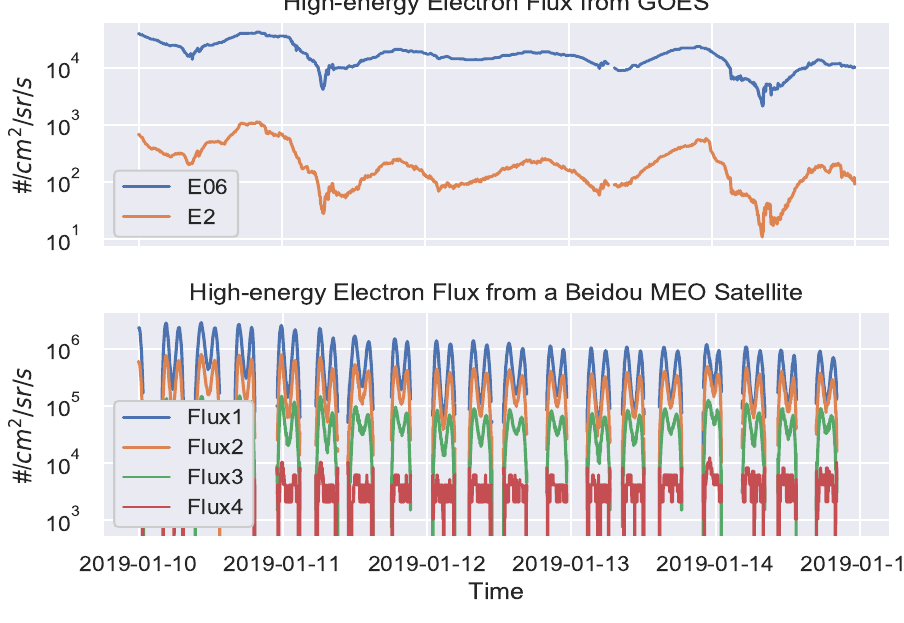
Figure 2. High-energy electron flux observations from 2019-01-10 to 2019-01-14 for GOES-15 over two energy channels (Top panel) and for a Beidou MEO satellite over four energy channels (Bottom panel).